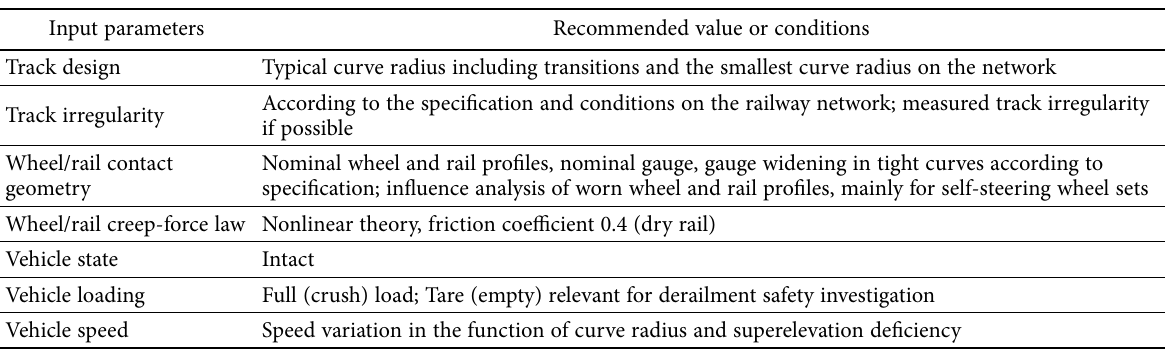
Table 1. Typical conditions for curving simulations